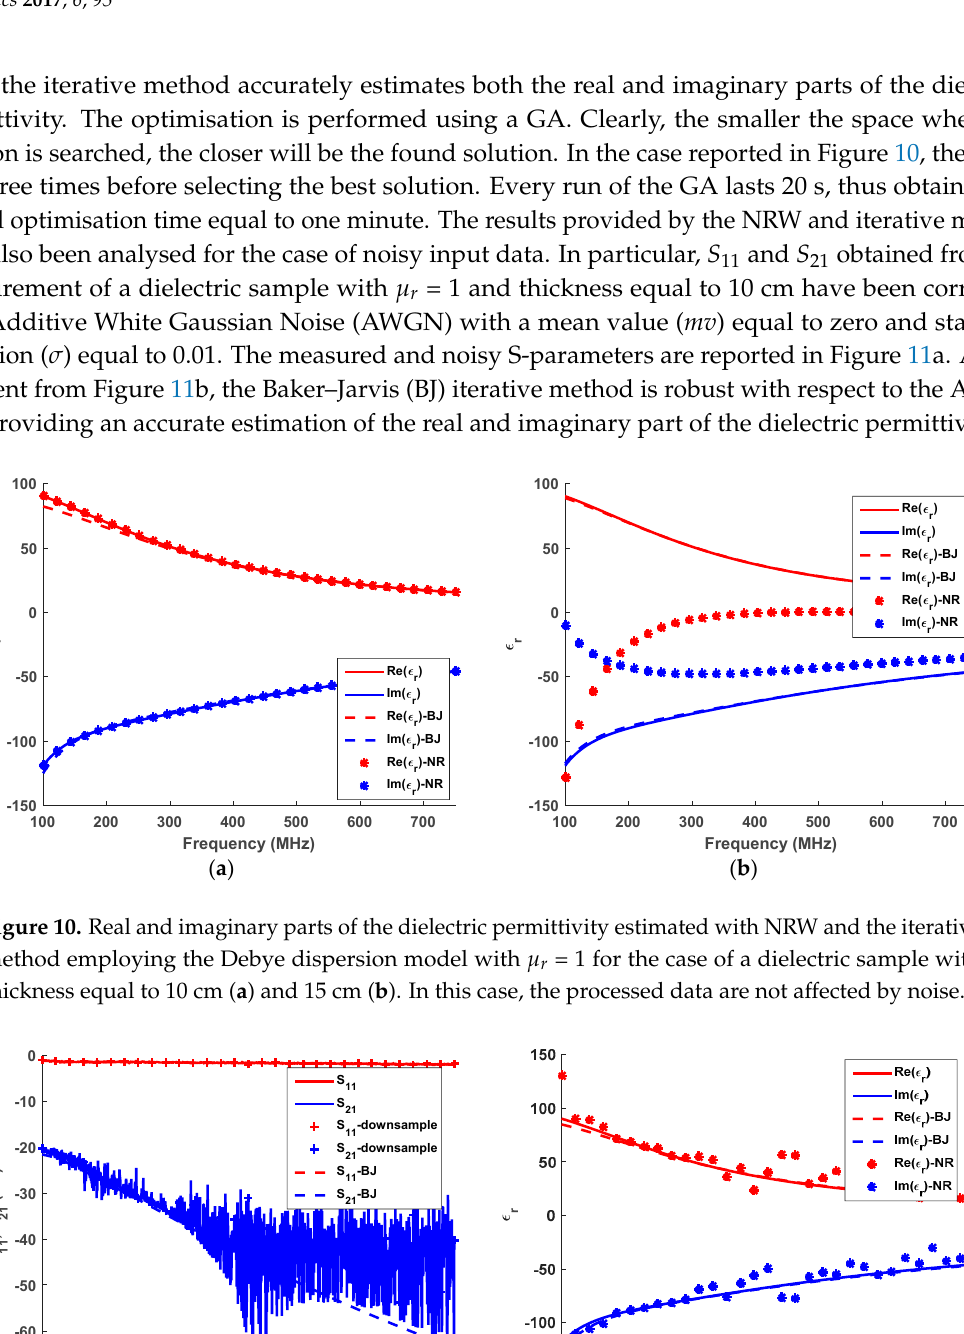
Figure 11. Comparison between the NRW and iterative method (BJ) employing the Debye dispersion model for the estimation of the dielectric permittivity with µ r = 1. ( a ) Measured, downsampled and GA-estimated S-parameters for the case of a dielectric sample with thickness equal to 10 cm; ( b ) estimated dielectric permittivity with the two methods. In this case the processed data are affected by AWGN noise with mv = 0 and σ = 0.01.